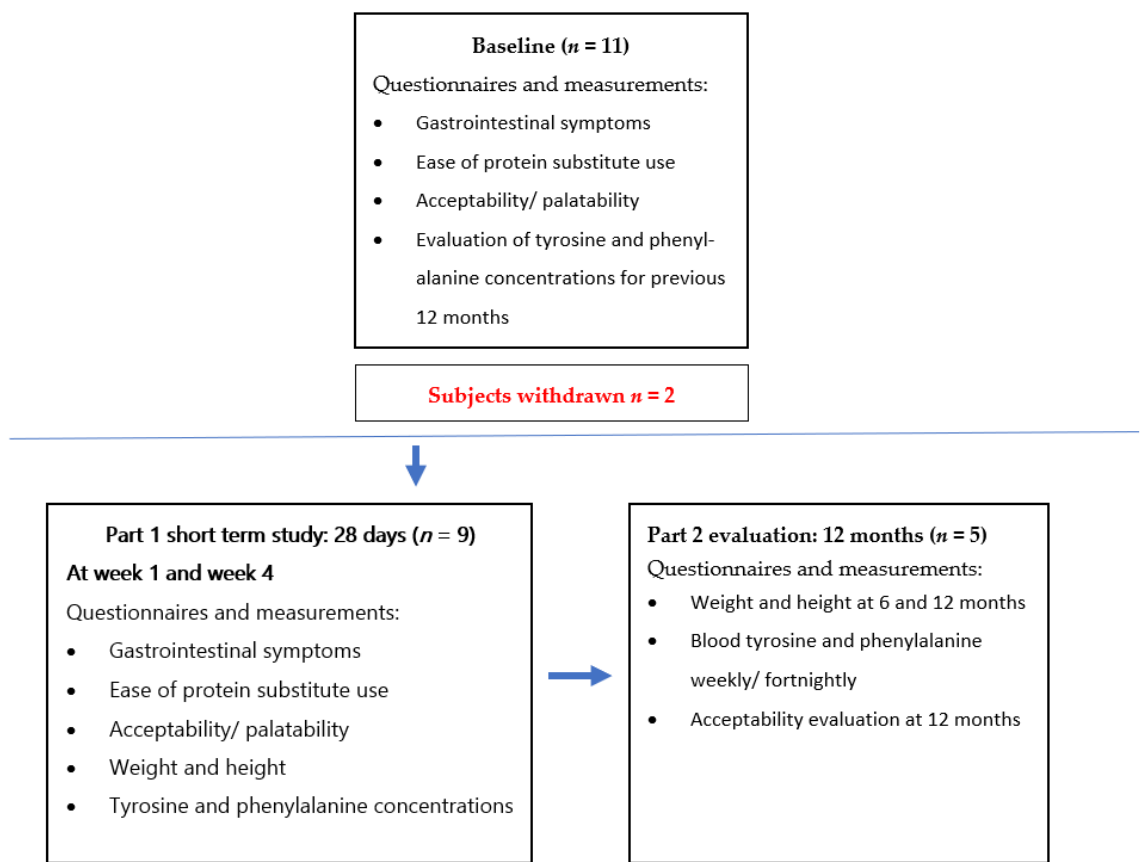
Figure 1. Diagram showing study design. Part 1: a short-term acceptability and tolerance study; Part 2: 12-month follow-up study in HTI children using a study product based on CGMP.